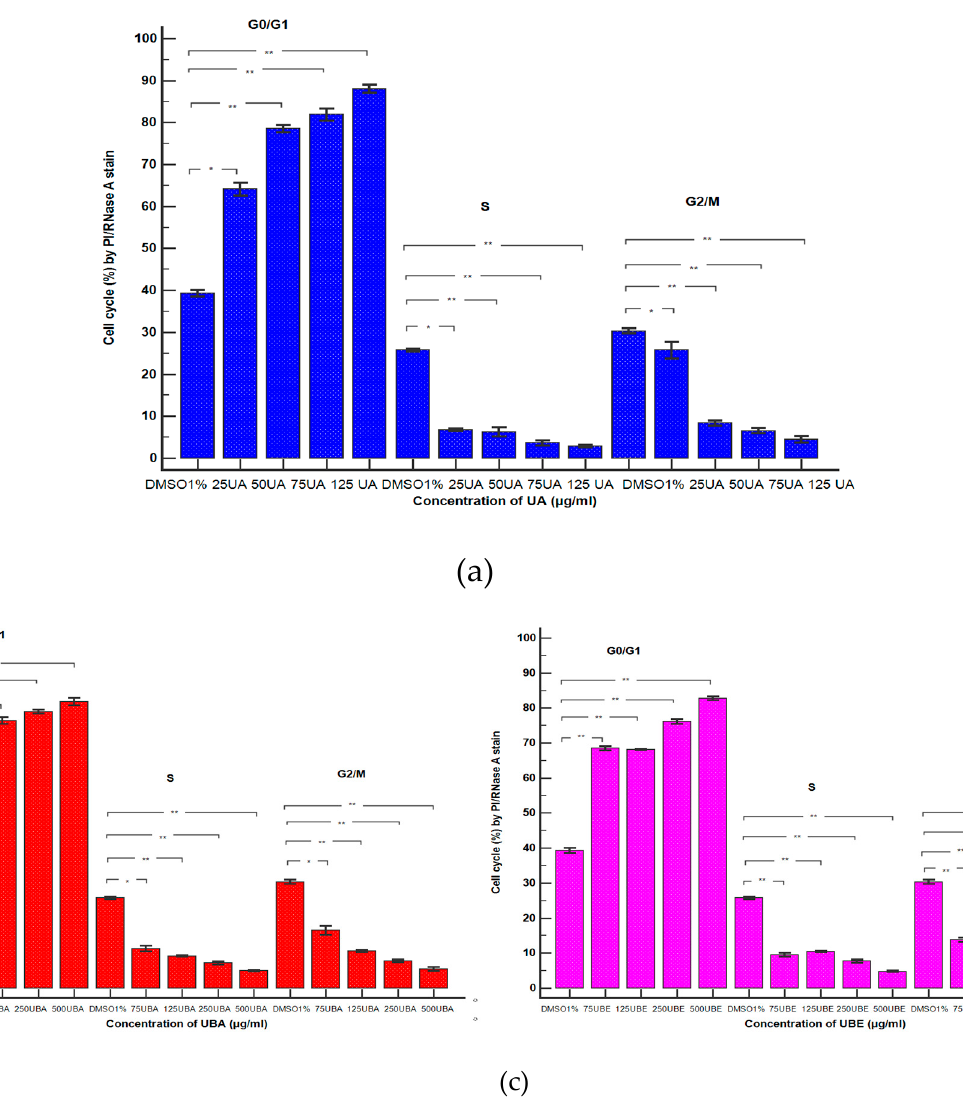
(e) Figure 11. Cell cycle model of UA, UBA, and UBE treatments in normal blood cell cultures. PI/RNase A patterns of UA 25, 50, 75, 125 μ g/mL A ( b – e ); B ( b – e ) UBA 75, 125, 250, 500 μ g/mL; C ( b – e ) UBE 75, 125, 250, 500 μ g/mL reported to 1% DMSO (Negative Control, A ( a ), B ( a ), C ( a )). As shown in Figures 11A (a–e) and 12a, UA concentrations of 25, 50, 75, and 125 μ g/mL induce a noteworthy cell cycle arrest in the G1/G0 phase: 64.13 ± 1.55%; 78.52 ± 0.87%; 81.91 ± 1.41%; 88.09 ± 0.98% vs. 39.29 ± 0.76%; p < 0.01, p < 0.001 compared to solvent control. This activity is directly proportional to UA concentrations. To understand whether the cell growth inhibition was due to cell cycle arrest, blood cells were treated with UBA of 75–500 μ g/mL concentrations (Figure 11B(a–e)). U. barbata